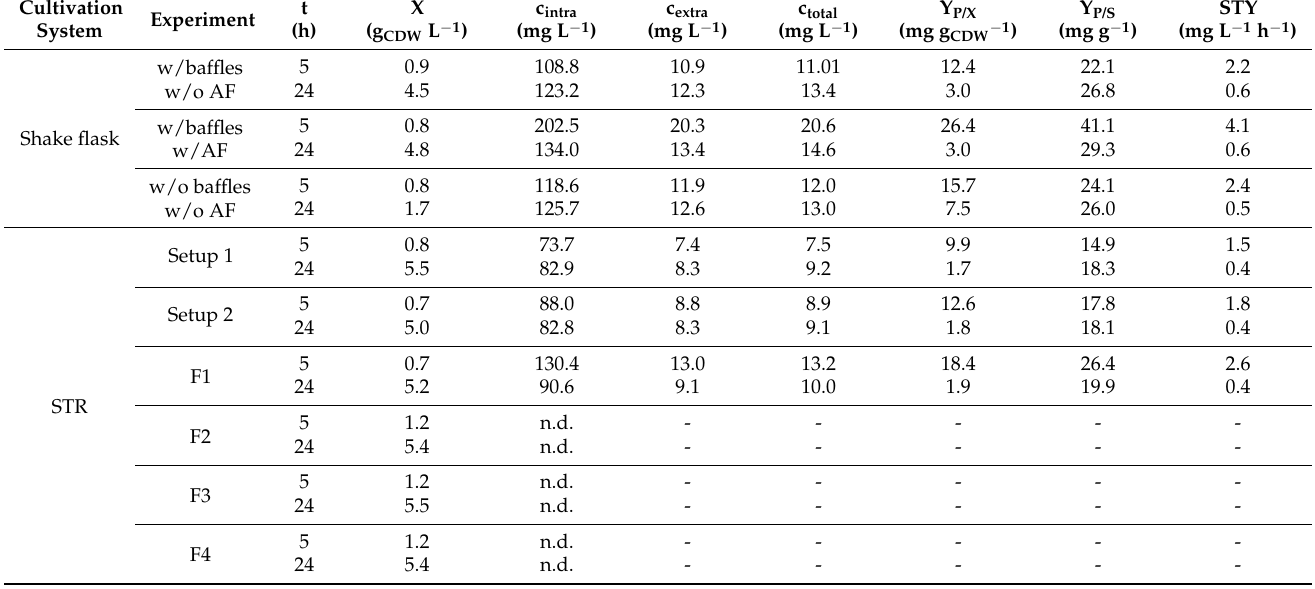
Table 2. Key bioprocess parameters Y P/X , Y P/S , and STY for SILR synthesis. Parameters were calculated from mean values for the two accumulation peaks at 5 and 24 h after